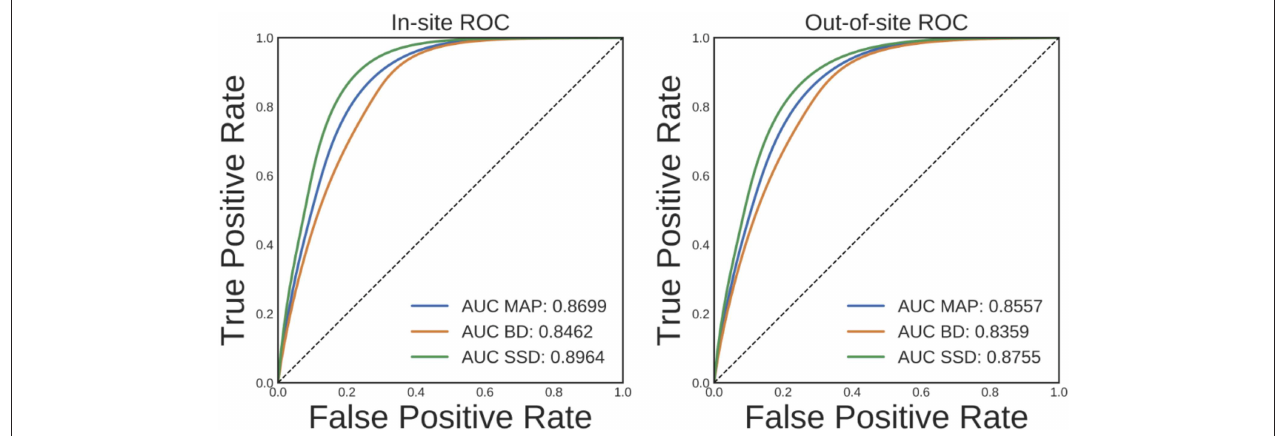
FIGURE 6 | Receiver operating characteristic (ROC) curves for predicting errors for the in-site and out-of-site test sets from the voxel uncertainty of the maximum a posteriori (MAP), MC Bernoulli dropout (BD), and spike-and-slab dropout (SSD) networks.